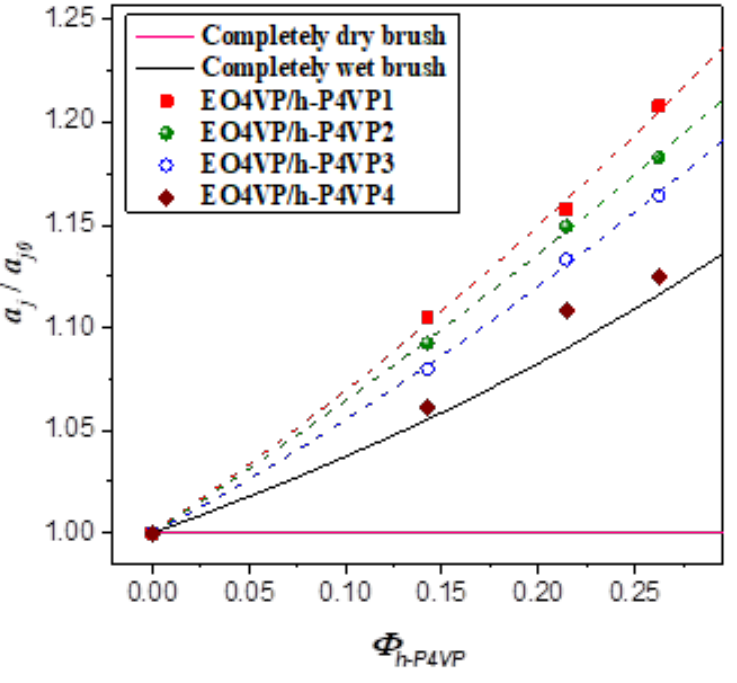
Figure 6. The normalized junction point separation a j / a j 0 as a function of the overall volume fraction of h-P4VP Φ h-P4VP of the blends at 180 ◦ C. The solid curves represent the normalized junction point separations calculated for the scenarios of dry-brush and wet-brush behavior with the assumption of unperturbed surface free energy.